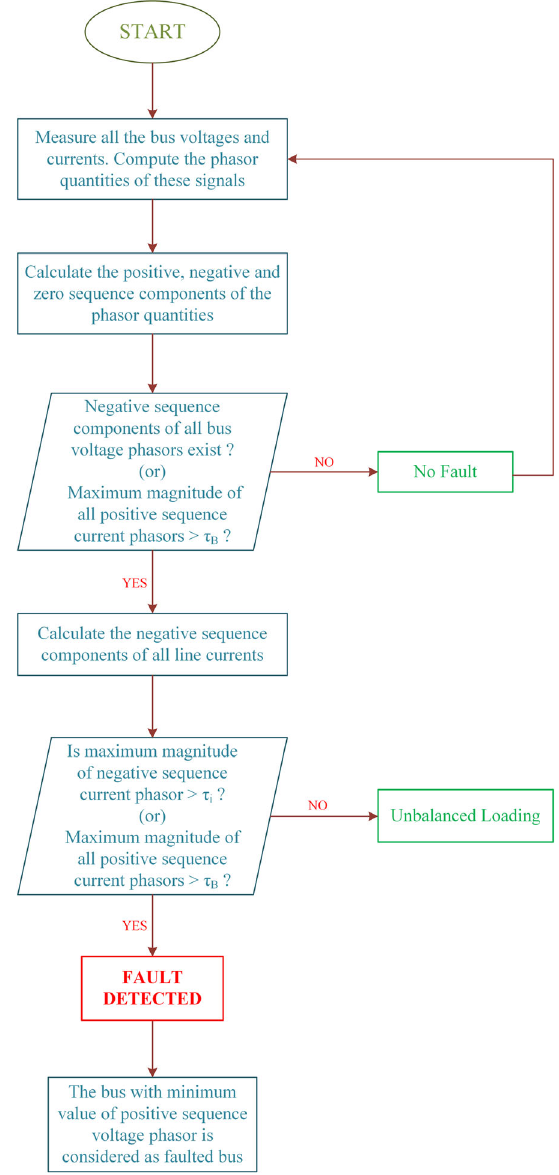
Fig. 2 Fault Detection